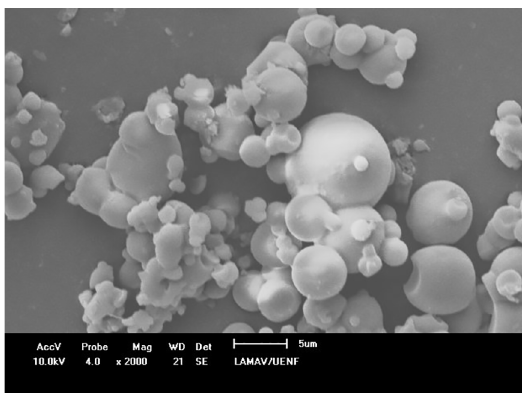
Figure 1. SEM micrograph of P(HB-HV):ND microcapsules with a magnification of 2000x.